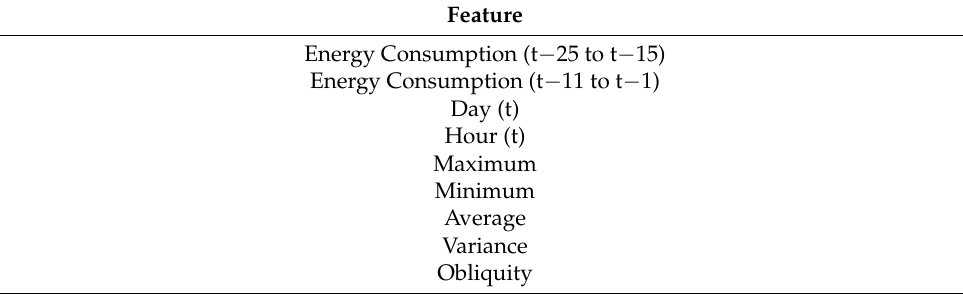
Table 9. Selected feature